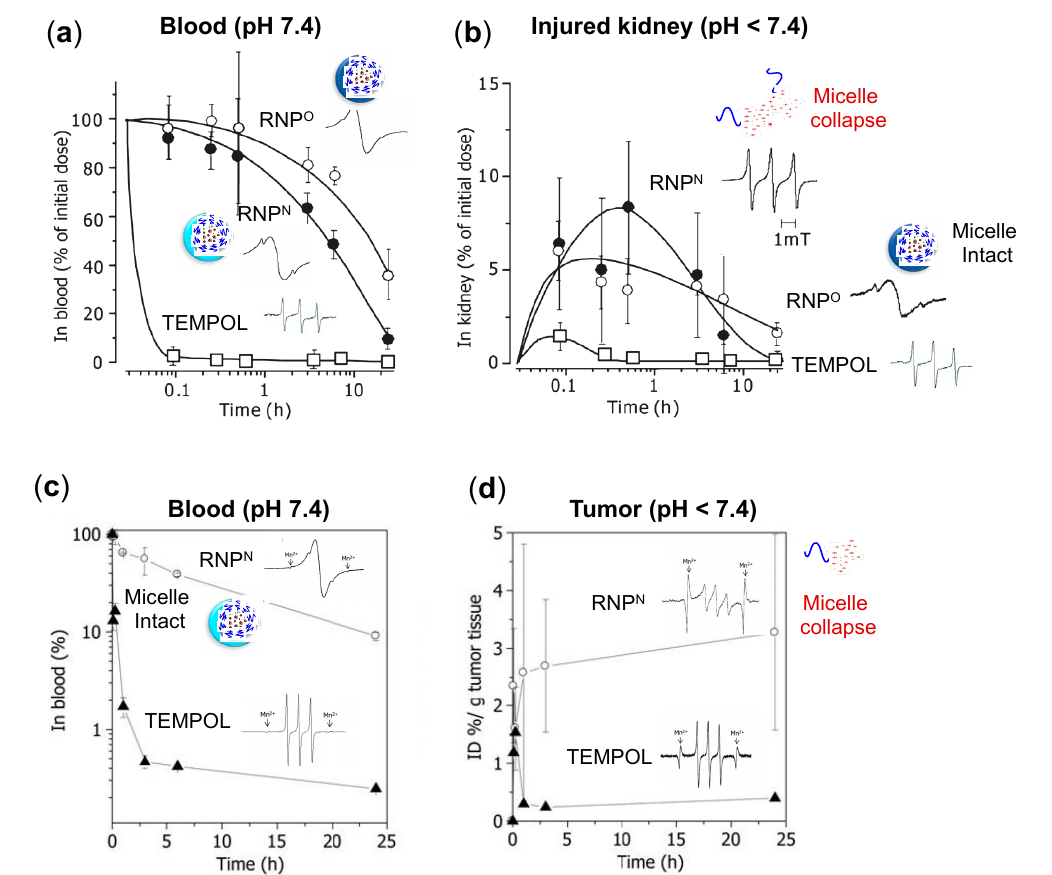
Figure 4. ( top ) Pharmacokinetic property of RNP N and RNP O in the blood and diseased organs. Time profile changes in the concentration of RNP O , RNP N , and TEMPOL; ( a ) blood and ( b ) injured kidney, after intravenous administration (75 mmol/kg of TEMPO concentration) in a renal ischemia-reperfusion induced acute kidney injury mice model [75,77]. The graph also displays ESR spectra of TEMPO radical of RNPs and TEMPOL. The ESR spectra of RNPs are broad under the physiological pH conditions (7.4), confirming their micelle integrity, in contrast with the sharp triplet peak of free TEMPOL. Under the decreased pH conditions, a typical diseased state, the pH-sensitive RNP N group shows sharp triplet ESR signals, indicating the micelle collapse as compared to pH-insensitive RNP O , whose micelle integrity is unaffected. ( bottom ). Biodistribution of RNP N and TEMPOL in a colon tumor (C-26 colon cancer cell line) bearing mice after intravenous administration with 40 mg/kg of TEMPO concentration; ( c ) blood and ( d ) tumor [82]. These data confirm that RNP N is stable in the blood (broad ESR signal), while it is collapsed in the tumor environment due to the reduced pH (sharp ESR peaks). This figure is reproduced with permission from References [75,77,82]. Copyright 2011, Elsevier; Copyright